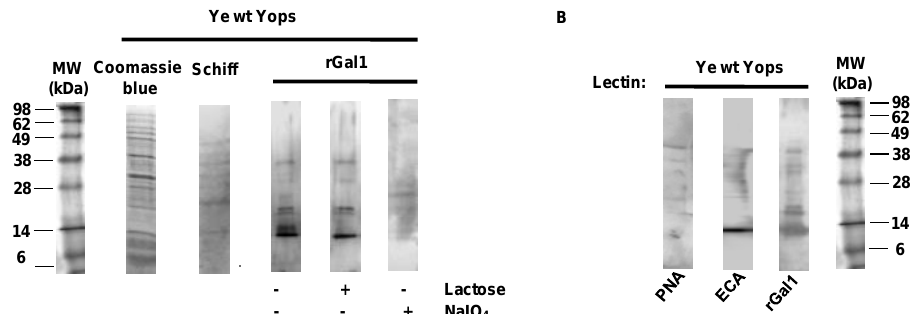
Figure 2. Virulence factors secreted by Y. enterocolitica are glycosylated and exhibit Gal1-permissive glycoepitopes. Electrophoresis was performed using an SDS-polyacrylamide gel (25 µ L per well of Ye wt Yops; 20–40 µ g/well). Subsequently, gels were ( A ) treated with rGal1 (6 µ g/mL), rGal1 and lactose (30 mM) or NaIO 4 (10 mM) or ( B ) incubated with biotinylated Peanut agglutinin (PNA) or Erythrina cristagalli lectin (ECA), capable of recognizing disaccharides with lactose-derived structures. Detection was performed by Coomassie blue staining, Schiff staining ( A ) or revealed by chemiluminescence ( B ). Data are representative of two independent experiments.